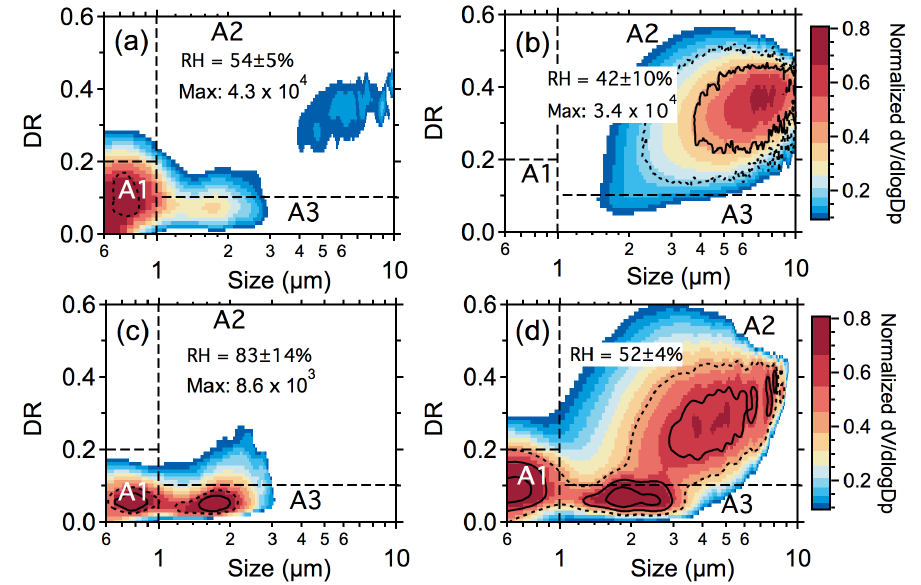
Figure 5. Variation in the depolarization ratio as a function of particle size for (a) anthropogenic-pollution dominant, (b) mineral-dust dominant, (c) typhoon influenced, and (d) mixed aerosol types. Colors represent normalized volume concentrations (maximum value = 1). The relative humidity (RH, from the Japan Meteorological Agency, http://www.jma.go.jp/jma/index.html) values in the plot are the means for each period.